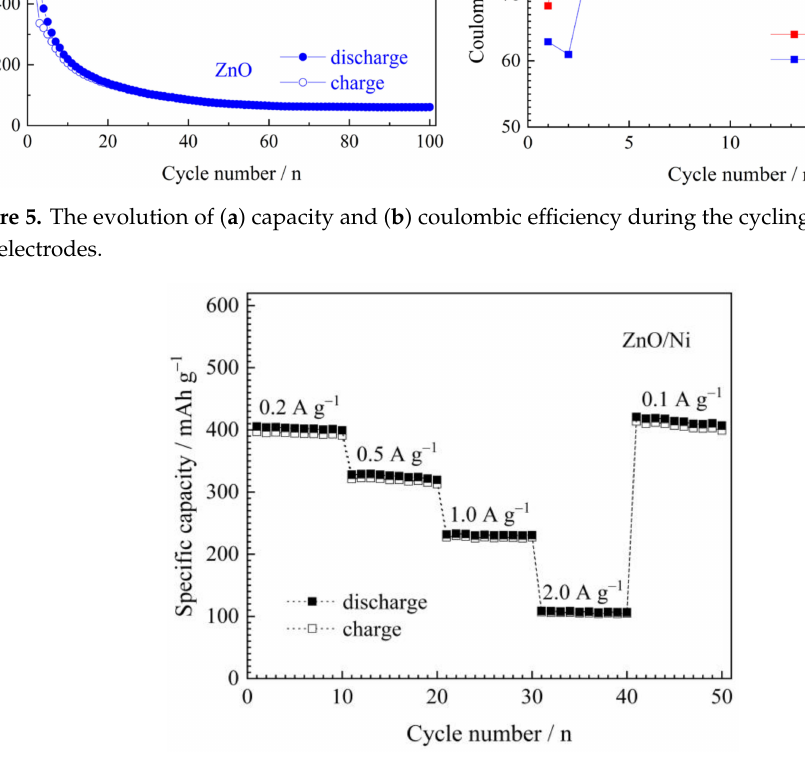
Figure 6. Rate capability of ZnO / Ni electrode tested at di ff erent current